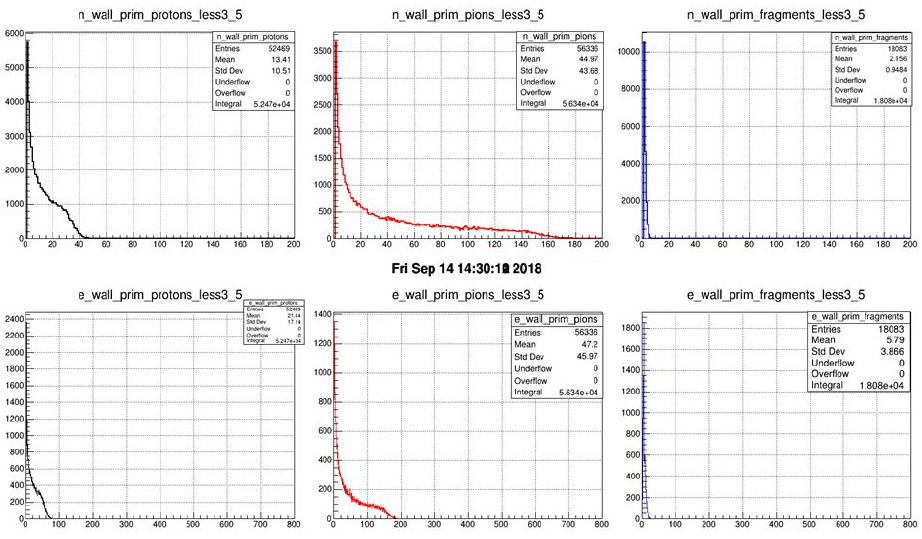
Figure 5. Same multiplicity and energy distributions for protons, pions and fragments as in Fig. 4, with condition that all charged particle with energy larger than 3.5 GeV are removed by anticoincidence with hadron calorimeter